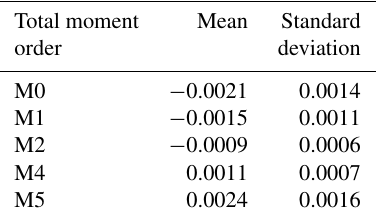
Table 2. Means and standard deviations of total moment tendencies (target values) for each statistical moment used. The data are cal- culated from Eq. (13) with the distribution parameters ( N 1 , µ 1 , σ 1 , N 2 , µ 2 and σ 2 ) as input values.